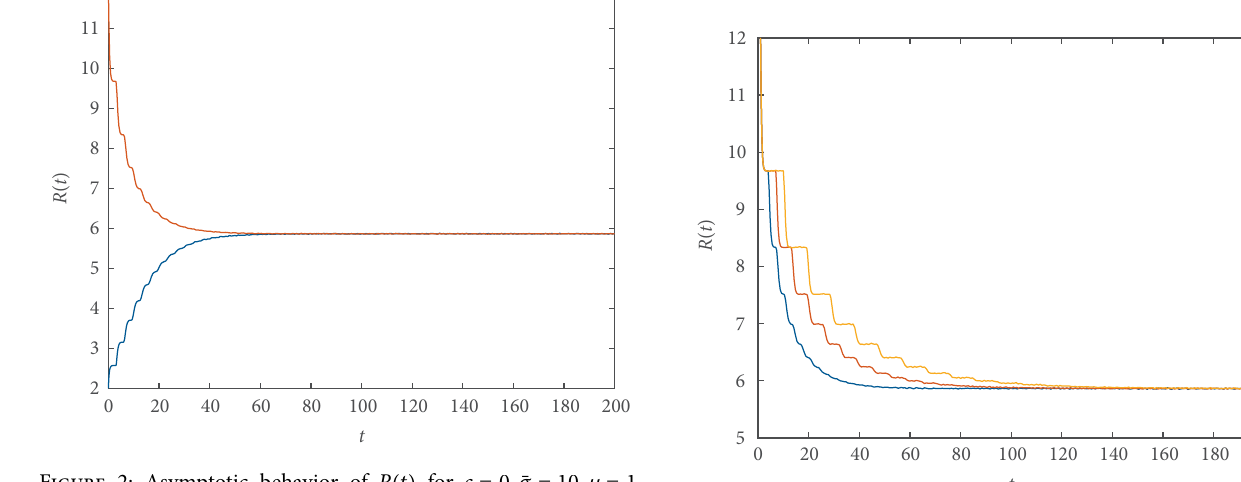
for 푐 = 0, ̄휎 = 10, 휇 = 1, 푅(푡)